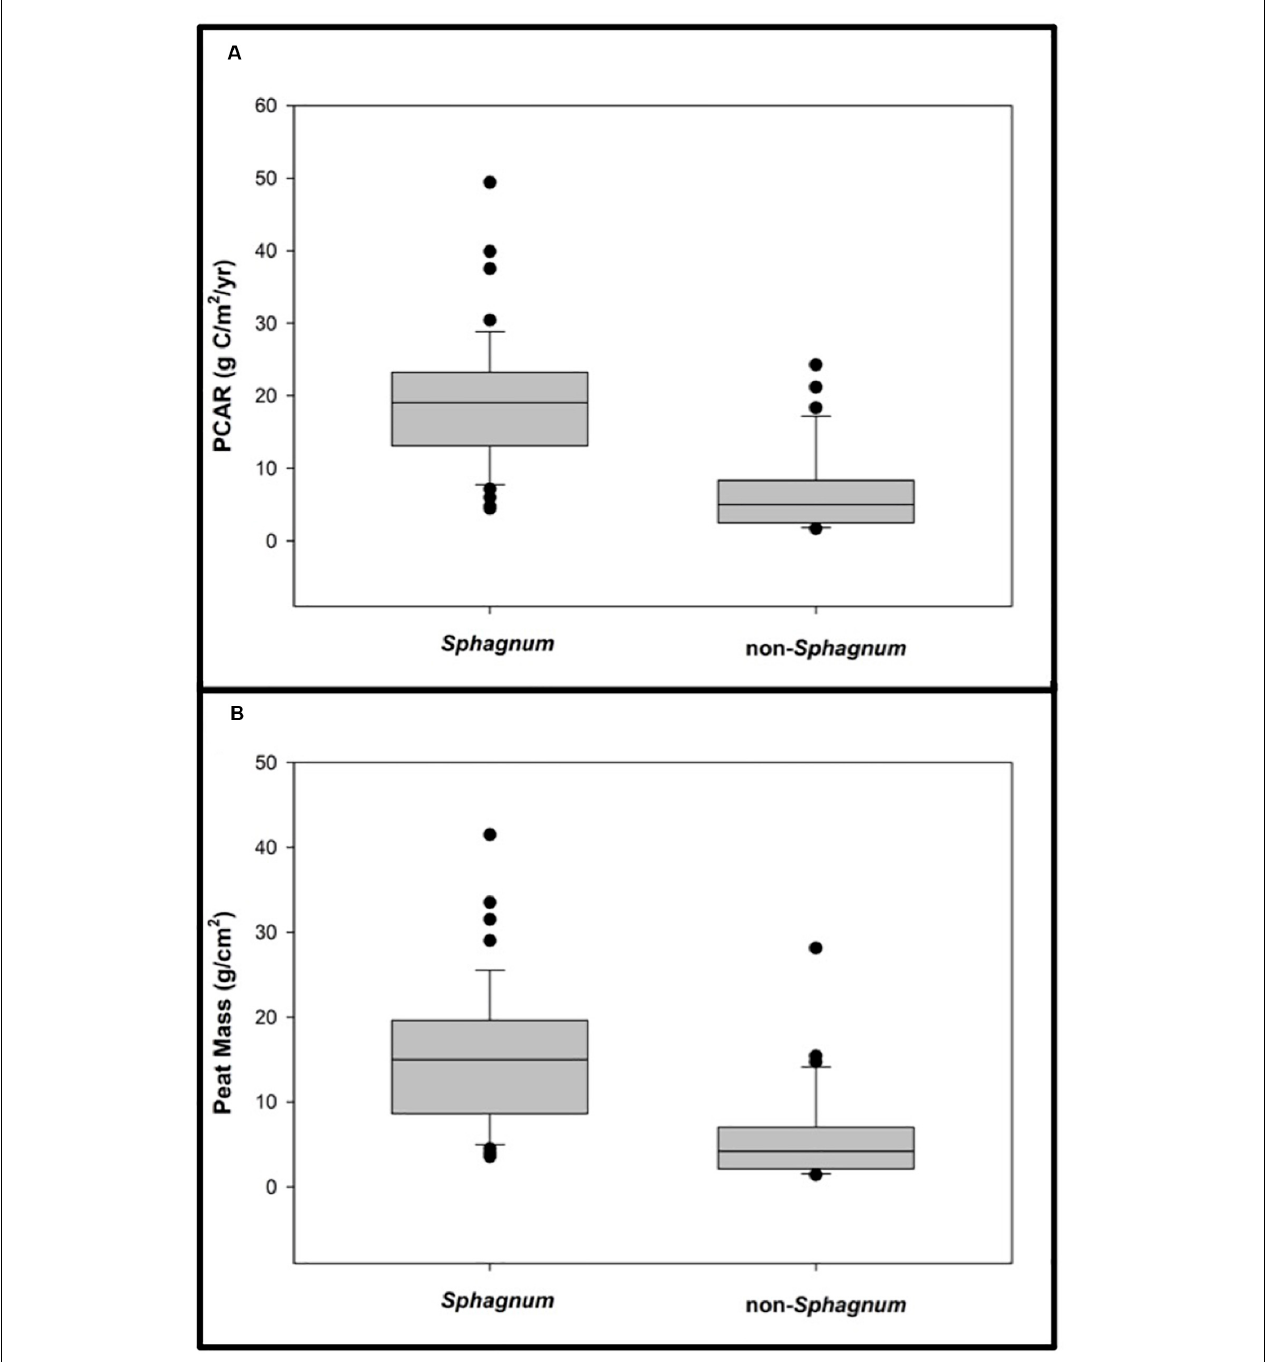
FIGURE 9 | A comparative analysis of Sphagnum vs. non- Sphagnum peat properties since the Mount Burney II eruption (4200 cal. yr BP). (A) Sphagnum vs. non- Sphagnum peat carbon accumulation rates since 4200 cal. yr BP. (B) Sphagnum vs. non- Sphagnum peat masses. Both analyses reveal that sites that switched to bogs accumulated significantly more peat (and stored more carbon) than sites that remained fens or cushion bogs (Tukey’s HSD: p <